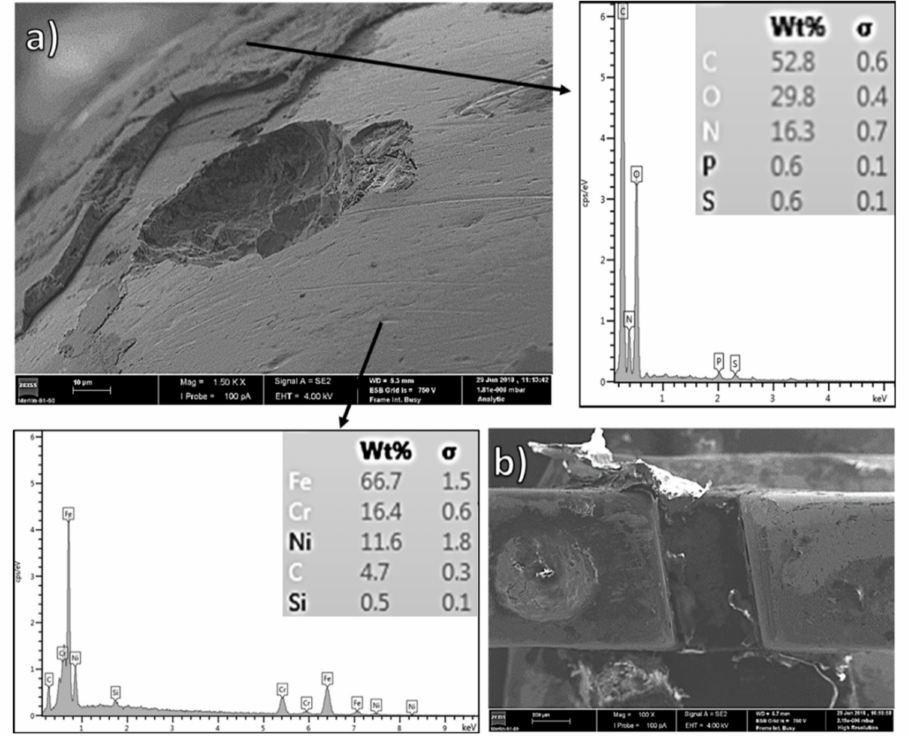
Figure 5. SS bracket after two years of intraoral use: SEM and OM micrographs coupled to EDS chem- ical compositions of the two distinct zones–stainless steel and biofilm-adherent surfaces. ( a ) pitting morphology underneath a biofilm layer, ( b ) biofilm accumulation.